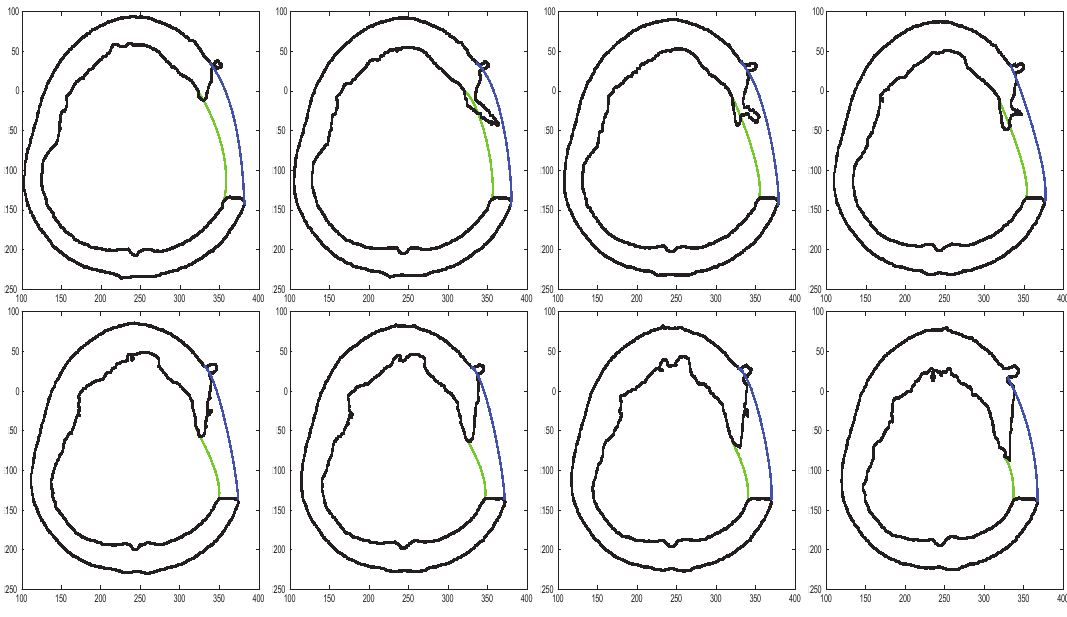
Figure 16. Construction of fractured parietal bone curves for different CT scan slices using a rational cubic Ball